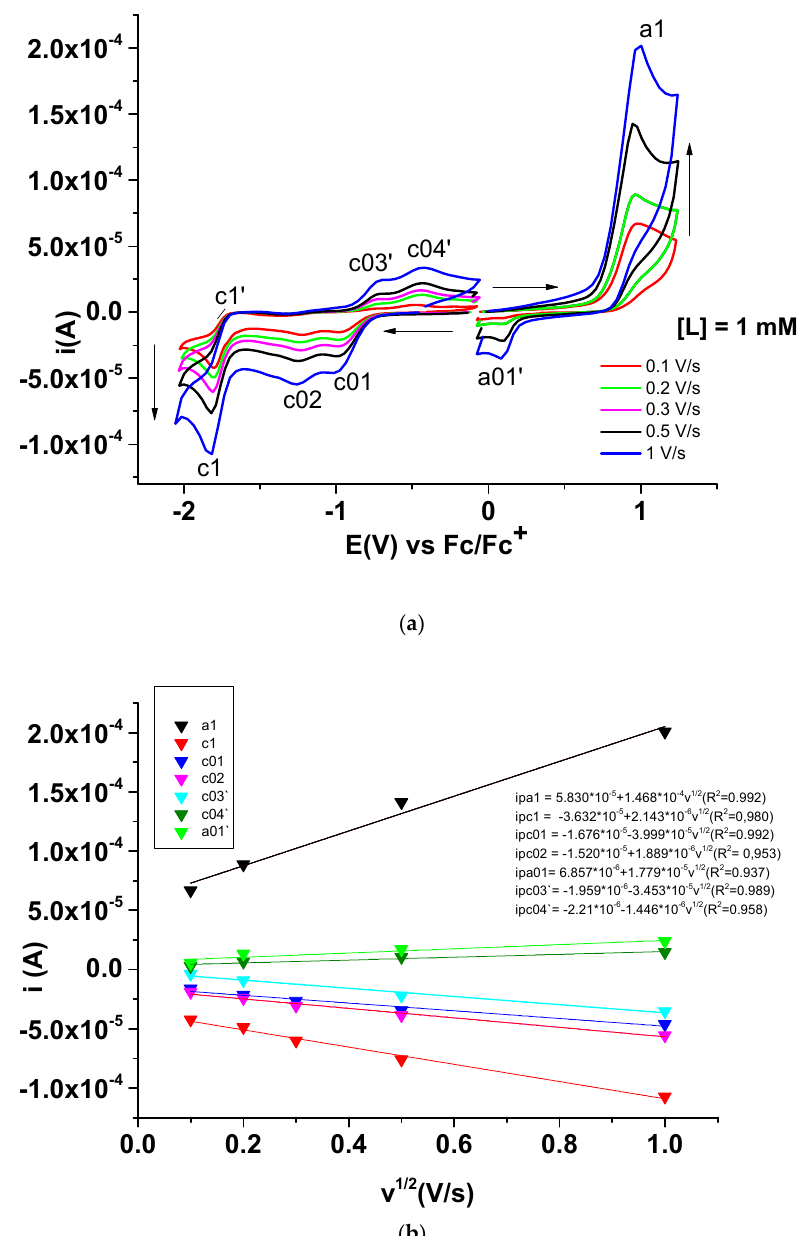
Figure 3. CV curves at different scan rates in 1 mM solution of L ( a ) and linear dependences of the currents for the peaks a1, c01, c02 and c1 on the square root of the scan rate ( b ).